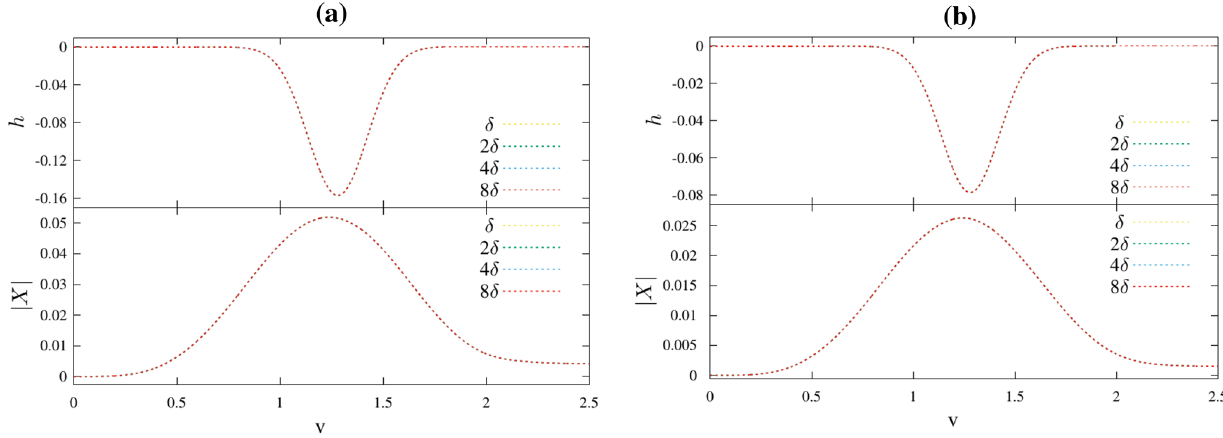
Fig. 19 The convergence of field functions. The scalar field, h , and the moduli of complex scalar field, | X | , were plotted versus v for evolutions conducted with integration steps, which were multiples of δ = 10 − 4 , along hypersurfaces of constant u equal to 1 for a evolution 1 and b